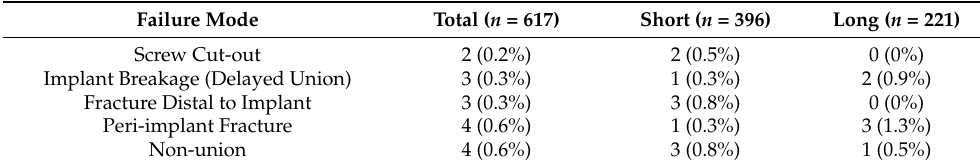
Table 2. Failure